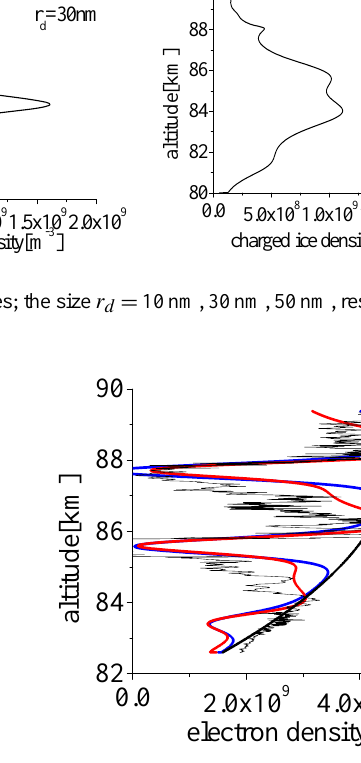
Fig.6 Gravity wave modulates the ion density distribution. (red solid line). The measuring result (black thin line) is also from the ECT02 rocket data